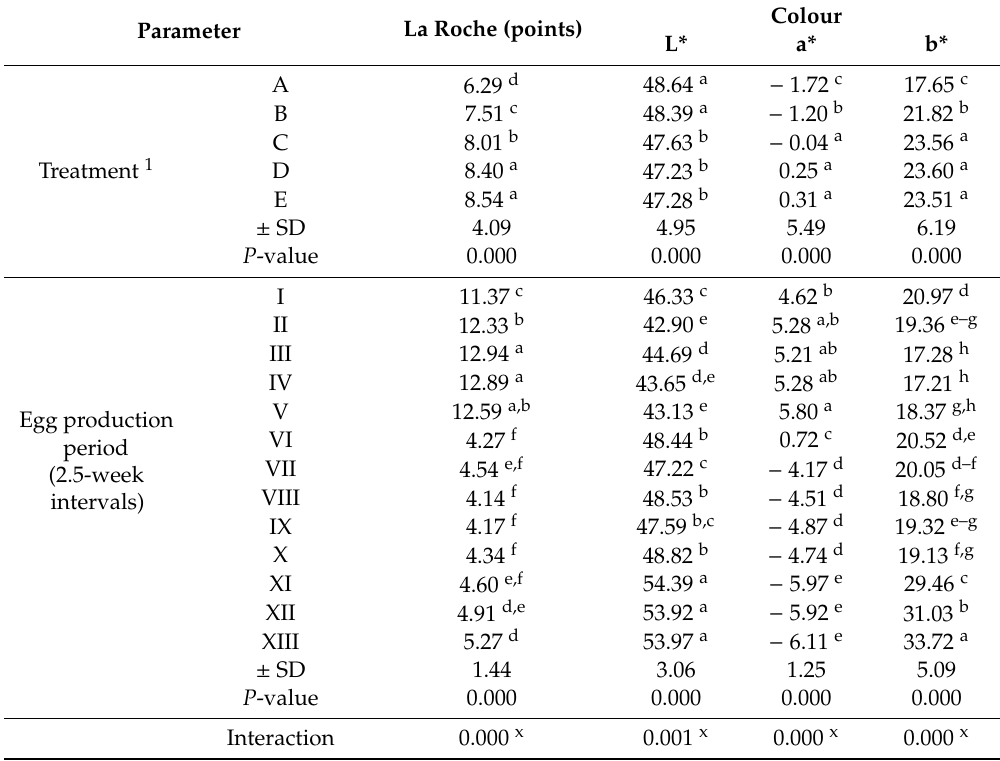
Table 6. Yolk colour (means ± SD